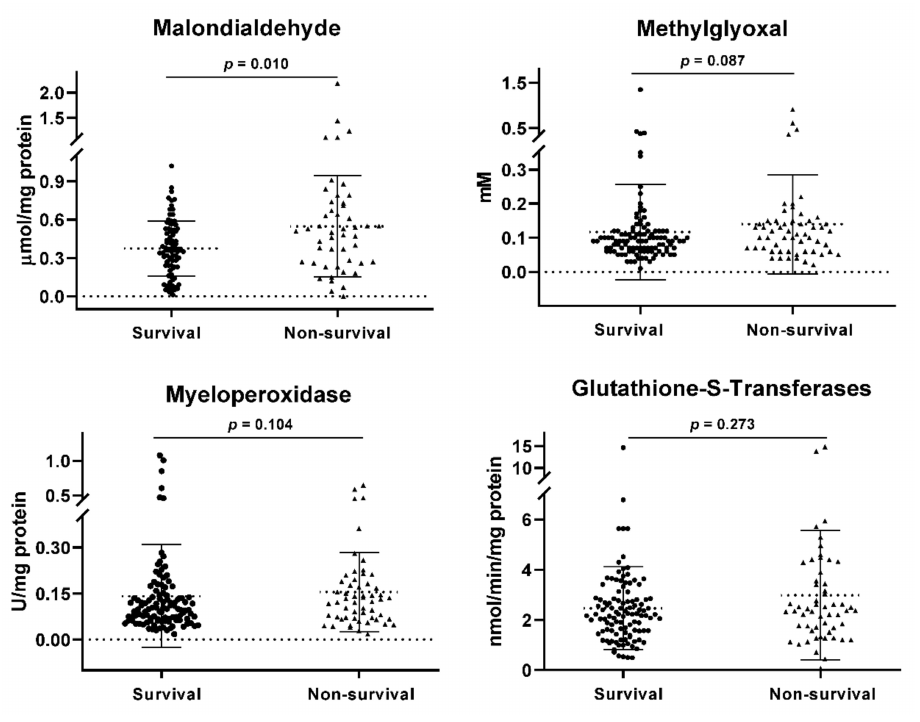
Figure 2. Oxidative stress biomarkers. A comparison of medians between the study groups was performed using the Mann-Whitney test. A p < 0.05 was considered statistically significant. Table 2. Plasma endothelial and oxidative stress biomarkers associated with mortality in hospitalized COVID-19